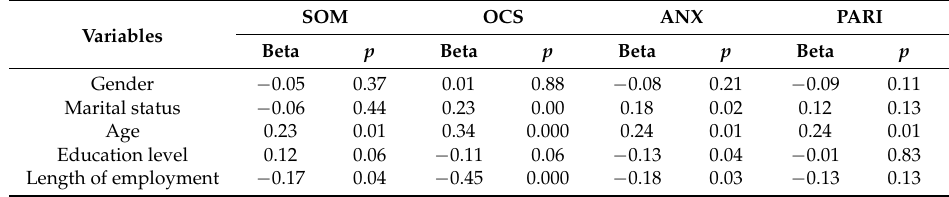
Table 3. Possible factors associated with respondents’ SOM, OCS, ANX, and PARI (Standardized Coefficients).